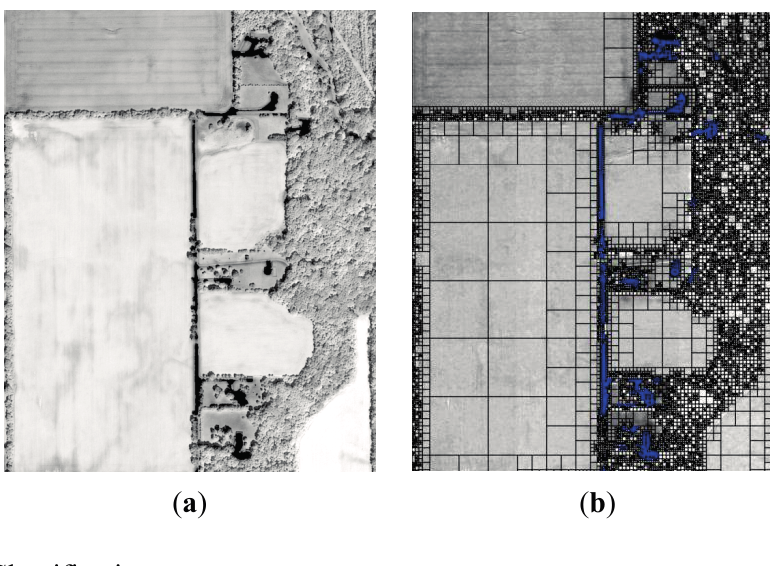
Figure 4. The quadtree-based (QT) segmentation partitions an image into objects of trees (small squares) and crops (large squares). ( a ) Image of PCA2 band within a 800 × 1000 pixels area. ( b ) After the QT segmentation, most of the large squres represent the crops, and most of the small squares represent the trees. The blue squares are the non-vegetation image objects with assigned classes, whose borders were inherated from the upper level of Multi-threshold (MT) segmentation